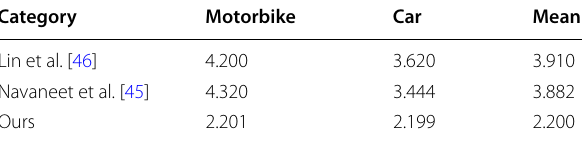
Table 5 Reconstruction error in Out-of-category tests Category